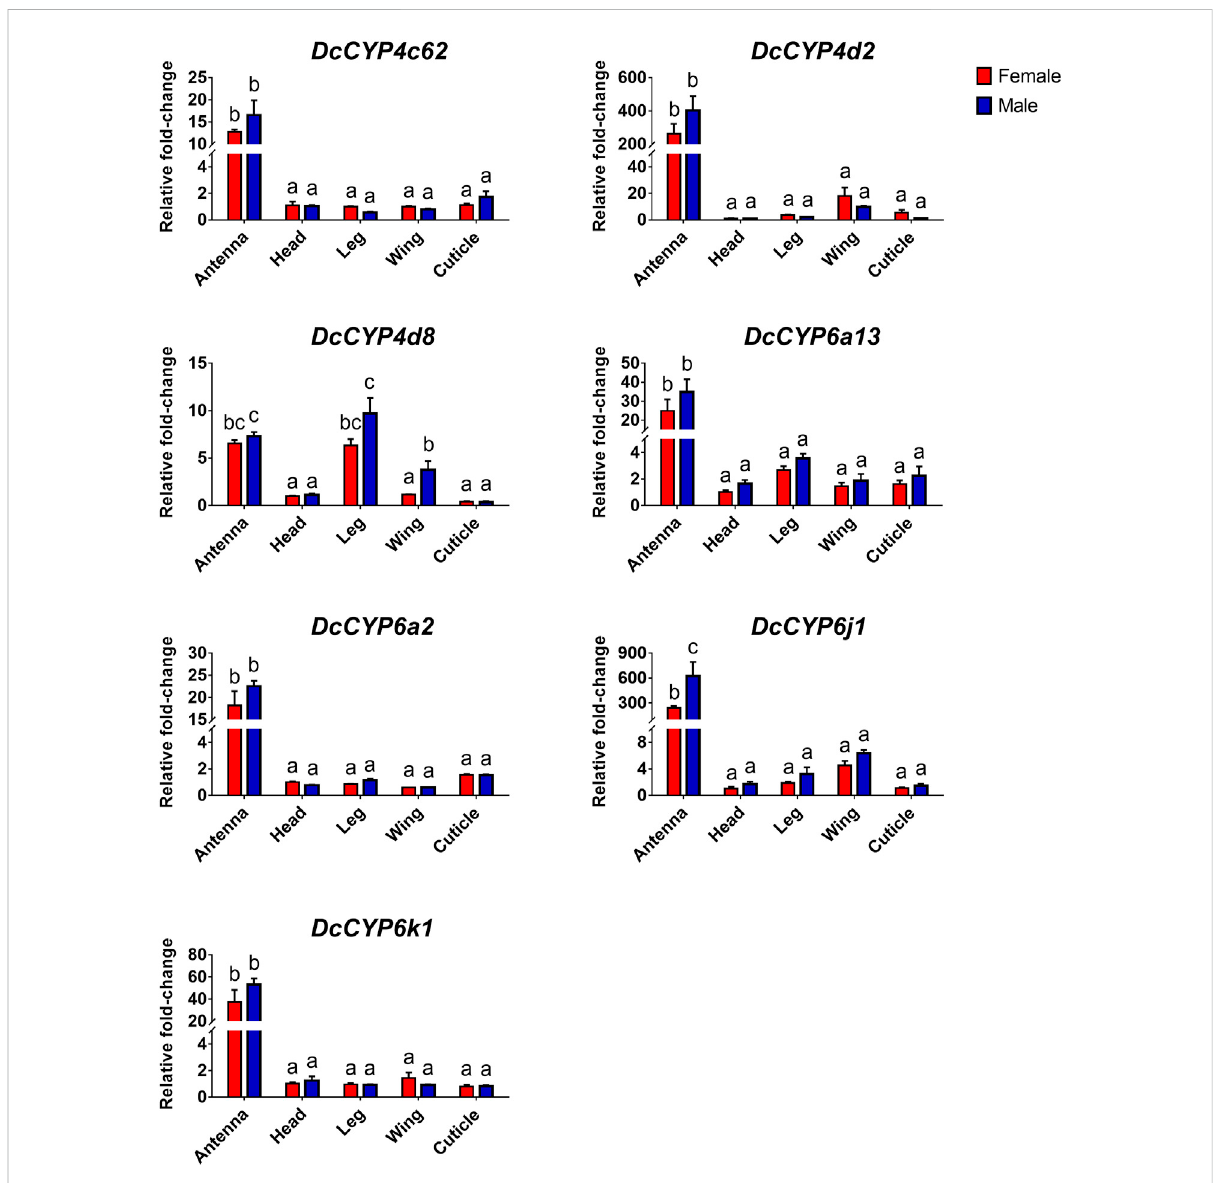
FIGURE 6 The relative abundance of DcCYP transcripts between different sexes and tissues. The expression level of DcCYP in female head was assigned anarbitraryvalueof1.Theexpressionlevelsinothersamplesarepresentedrelativetotheaveragefemaleheadlevels.Differentlettersabovetheerror bar indicate signi fi cant differences among female and male tissues ( p < 0.05; two-way ANOVA, Tukey ’ s multiple comparisons